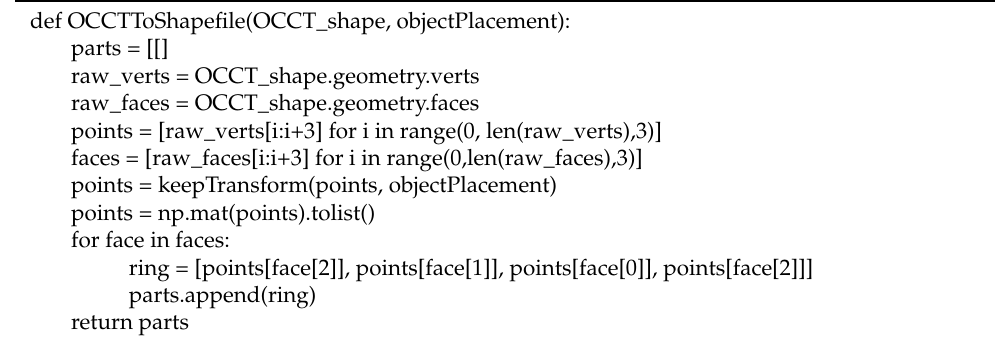
Table 4. Python codes for geometry conversion and coordinate transformation.